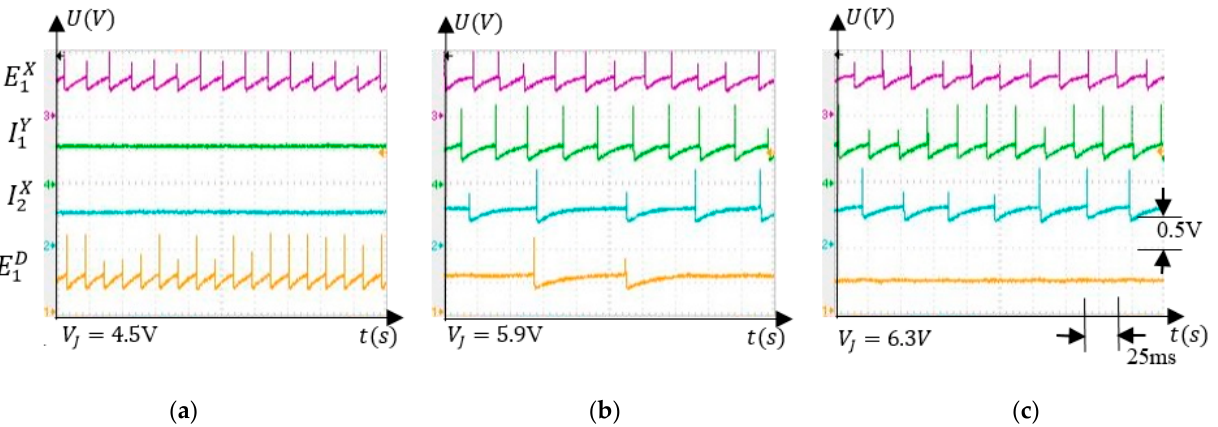
Figure 7. Activity of the neurons that stimulate (cid:1831) (cid:2869)(cid:3005) when (cid:1848) (cid:3011) takes several values; ( a ) no inhibition; ( b ) partial inhibition; ( c ) ful inhibition.